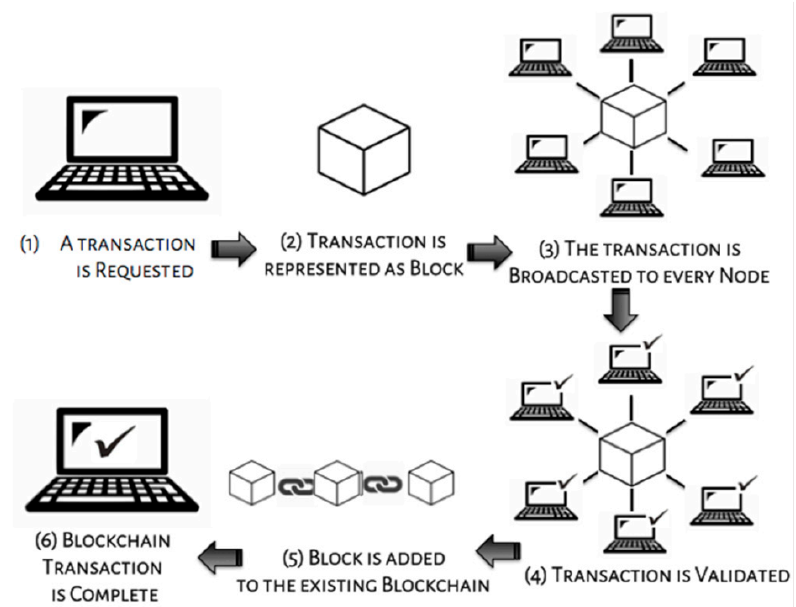
Figure 7. Working of